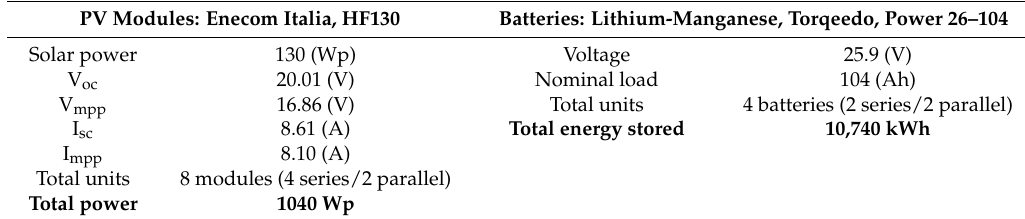
Table 1. Parameters describing the PV modules and batteries.